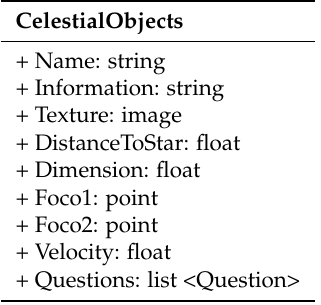
Table 2. Model of celestial